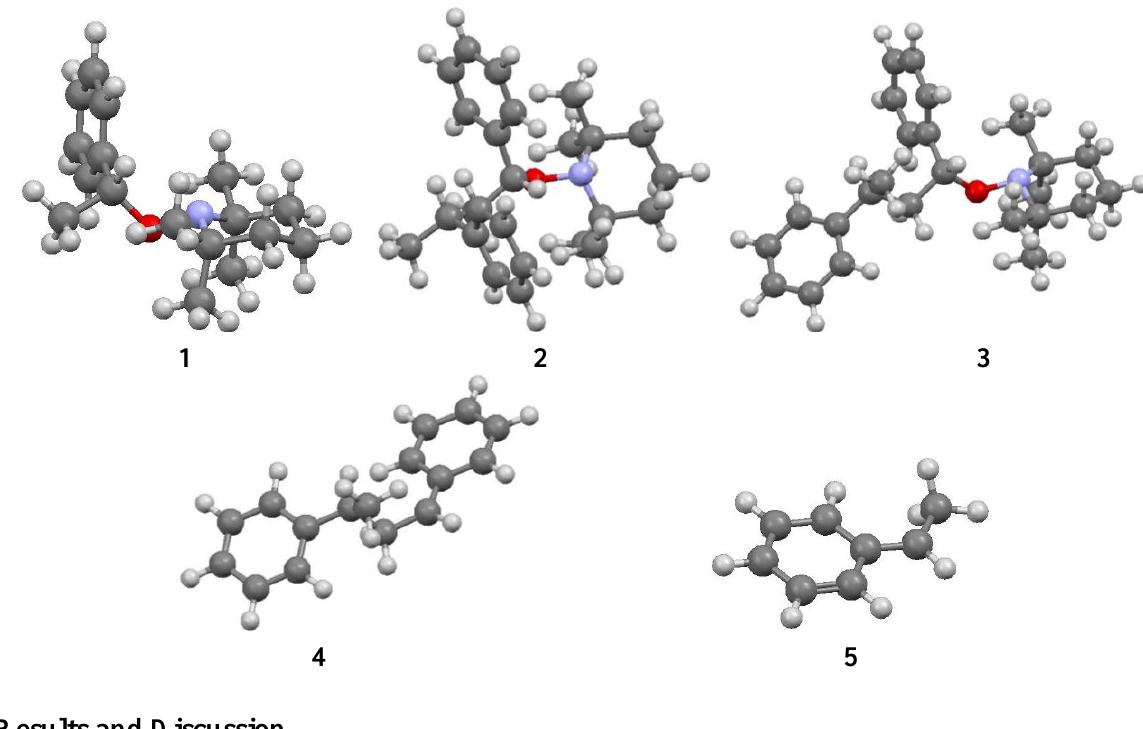
Figure 2. DFT calculated structures for molecules 1 – 5